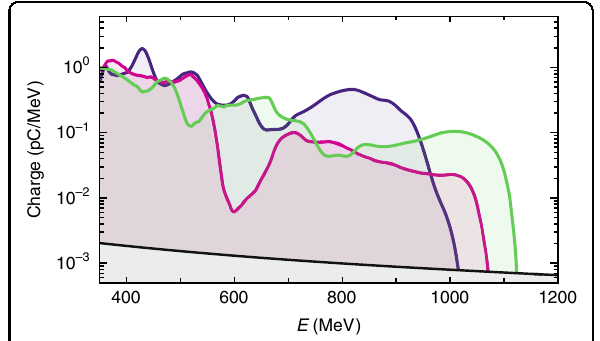
Fig. 3 Acceleration of electron beams with broad energy distributions. Three consecutive electron spectra obtained using ionization injection. The black line indicates the detection